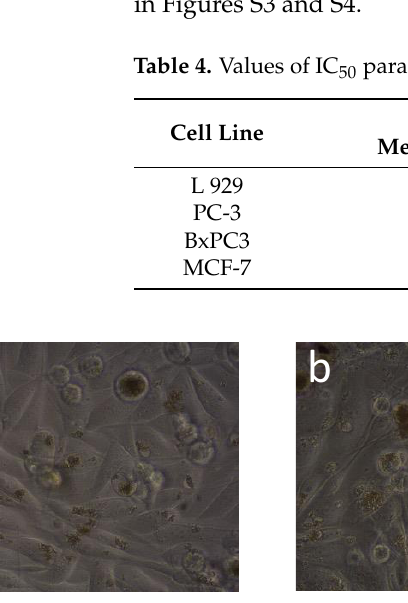
Figure 5. PC-3cells incubated with different concentrations of nanoparticles: 10 µg/mL ( a ), 50 µg/mL ( b ), 200 µg/mL ( c ). The main cause of the cytotoxic effect of nanoparticles at the cellular level is due